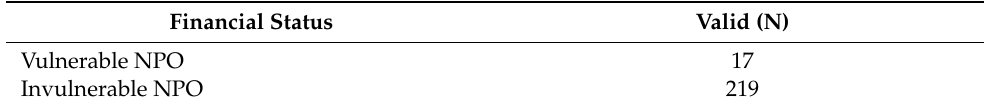
Table 8. Case Processing Summary.